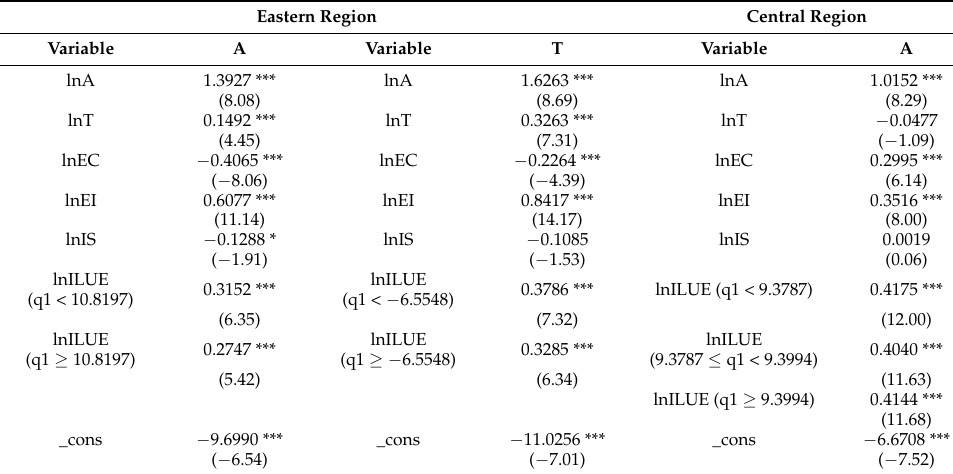
Table 5. Threshold A regression results in the eastern, central, and western